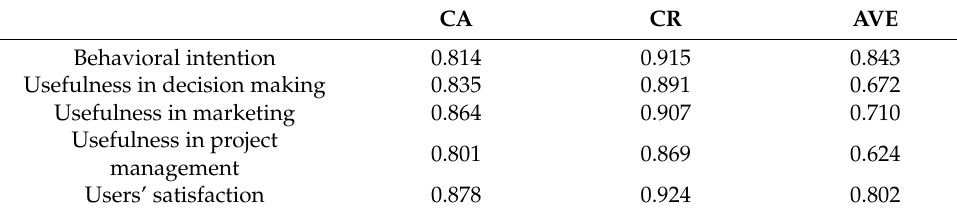
Table 3. Validity and reliability.